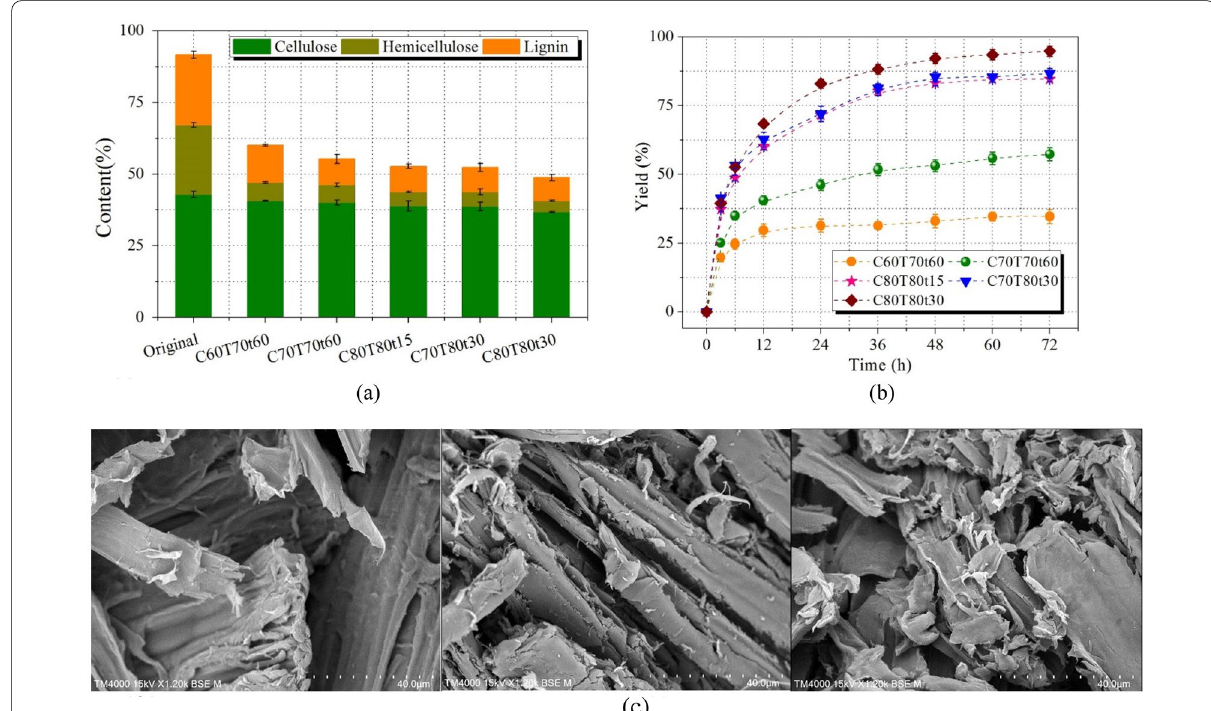
Fig. 2 a Content of three components in the pretreated substrates (Cx stands for the acid concentration; Tx stands for the temperature; tx stands for the time), b Enzymatic saccharification of the pretreated substrates. c SEM images of raw material, the pretreated substrates obtained from C70T70t60 and